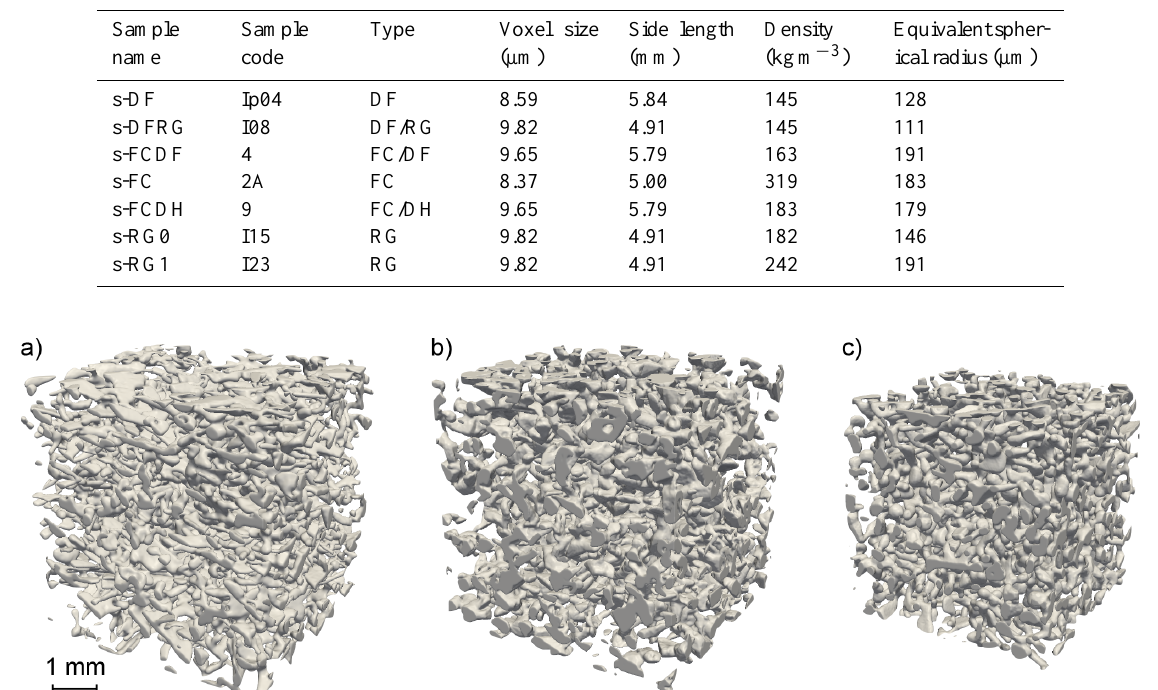
Table 1. Description of the microtomographic images used in this study. All images are cubic. Density and equivalent spherical radius were computed directly from the binary images. The equivalent spherical radius r eq is defined as 3 V/S , with V the volume of ice and S the snow surface area. It represents a typical length scale of the ice matrix.